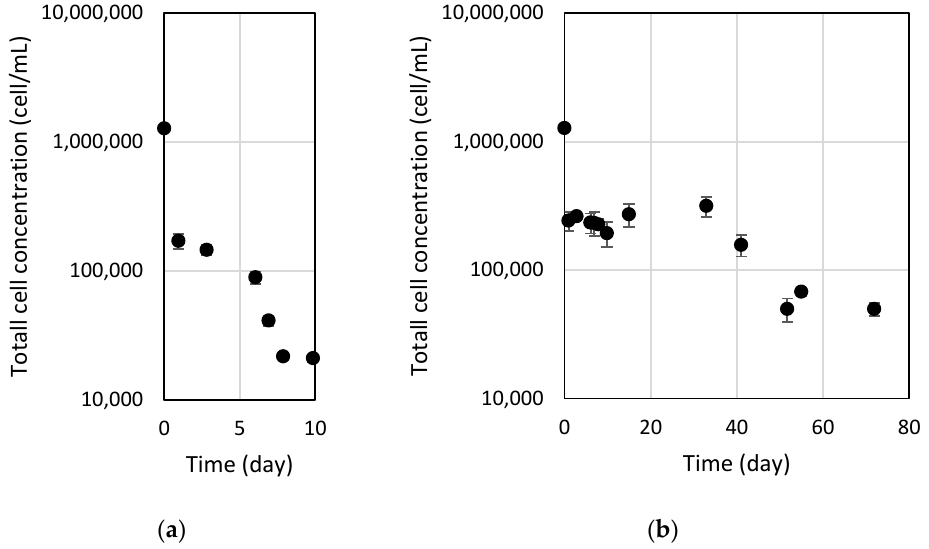
Figure 3. Dunaliella salina total cell concentration in ( a ) dark and ( b ) light conditions with time. Stokes’ law (Equation (1)) was used to predict the settlement velocity of Dunaliella salina . The density and the viscosity of the medium, obtained from the literature for seawater with 12% salinity, were considered to be 1090.25 kg/m 3 and 1320.6 µ Pa · s, re- spectively [32]. According to previous research, the density of the cytoplasm of marine microalgae ranges between 1030 and 1100 kg/m 3 [33]. Another study considered the density of Dunaliella salina as 1260 kg/m 3 , the density of glycerol [34]. Due to the small density difference between the microalgae and the medium, it can be said that density contribution to settlement is small compared to the size of the microalgae. Stoke’s law holds for spherical shaped microalgae, so Dunaliella salina was assumed to be spherical. The average size of Dunaliella salina was 12.5 µ m, so for a radius of 6.25 µ m, the settlement velocity is expected to be around 0.05 m/day. This value is not in accordance with experi- mental results probably because Dunaliella salina is a motile microalgae, which makes it more difficult to predict its settlement. Flagella are considered a dynamic morphological means to suspension [33], and thus, complex hydromechanical [35] and biophysical [36] parameters might be considered for settlement prediction